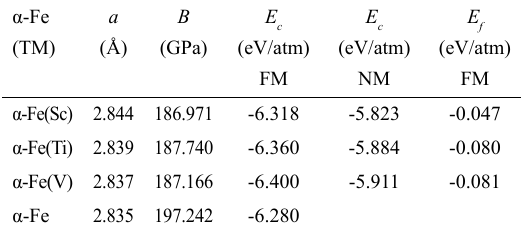
), bulk modulus ( B ) and lattice constant ( a ) for α-Fe(TM) (TM f = Sc, Ti and